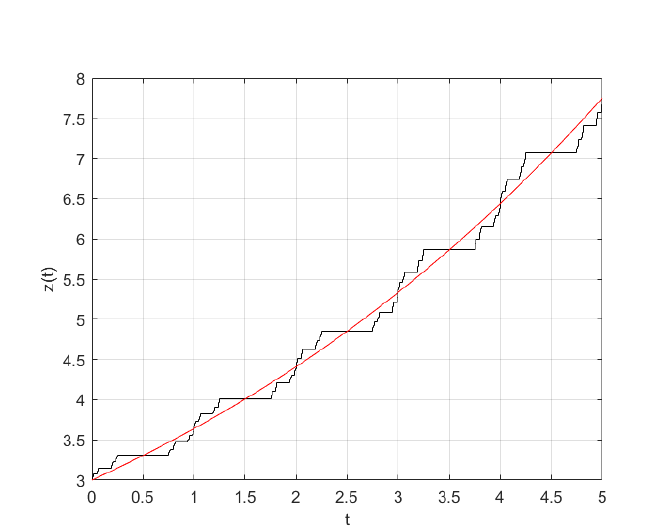
Figure 3. Fractal logistic curve with α = 0.5 where µ = 1/2. z ( 0 ) = 3, r K = 100, r (cid:48)